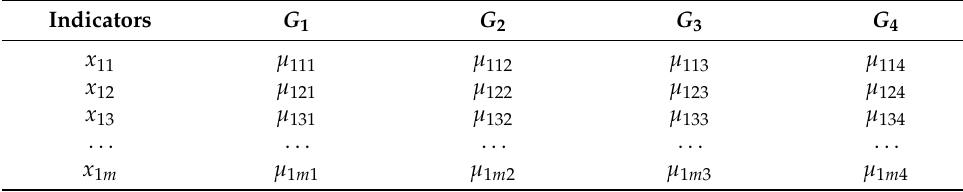
Table 3. Calculation of single-indicator connection